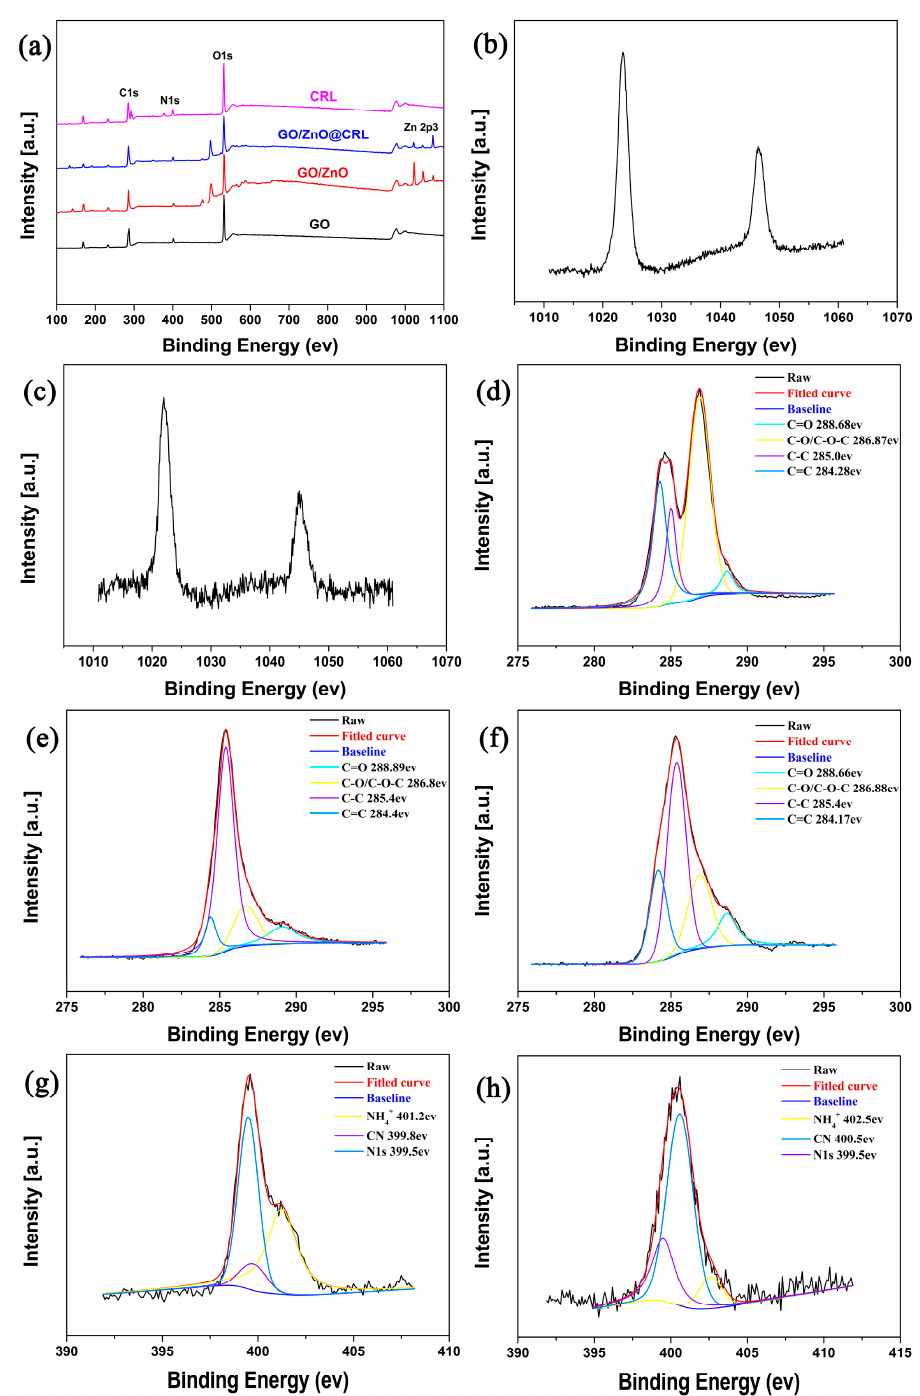
Figure 2. X-ray photoelectron spectroscopy (XPS) spectra scans; ( a ) wide scan XPS spectra of the supporting materials, high-resolution XPS spectra of Zn 2p scan ( b ) GO/ZnO, ( c ) GO/ZnO@CRL, C 1s spectra of ( d ) GO, ( e ) GO/ZnO and N 1s spectra of ( f ) CRL and ( g ) GO/ZnO@CRL.